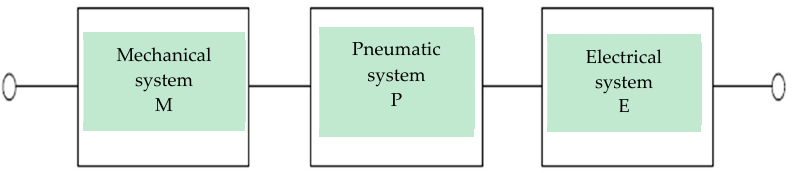
Figure 3. The basic reliability block diagram of the loading and unloading truss robot for CNC